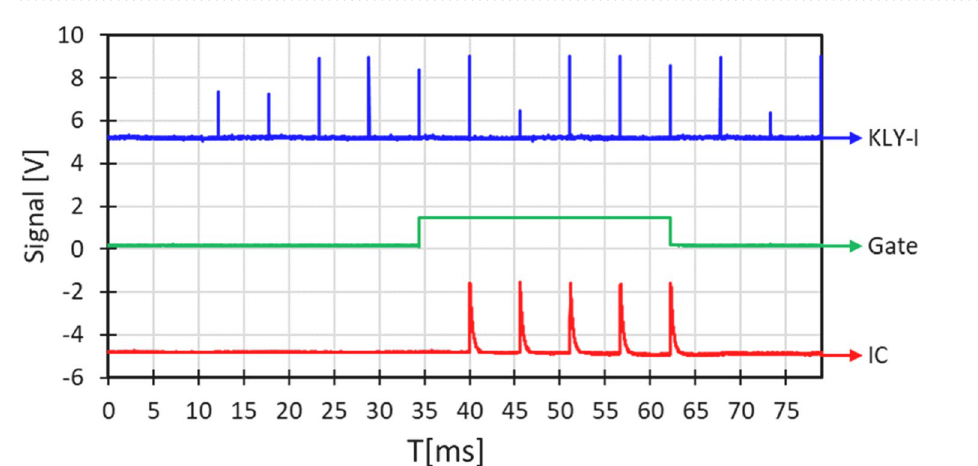
Figure 3. Oscilloscope trace of KLY-I, the CTR08-generated beam enable signal (Gate) and the built in ion chamber (IC). This irradiation was programmed to deliver 5 pulses after a delay of 5 pulses (25 ms). Variation in KLY-I pulse height is due to undersampling—pulses are all 5 V. KLY-I and IC traces offset by ± 5 V to facilitate